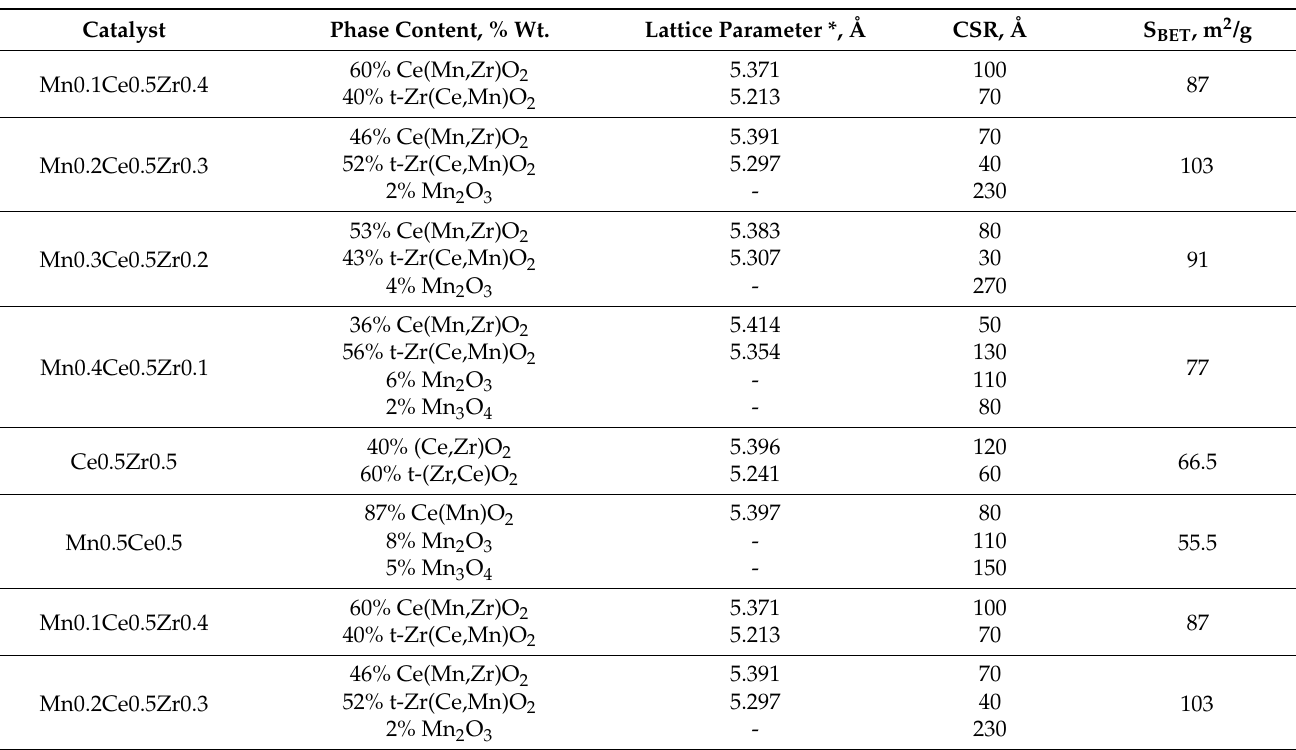
Table 1. Phase composition, lattice parameter of solid solution (Ce(Mn,Zr)O 2 , and t-Zr(Ce,Mn)O 2 CSR and surface area of (Mn,Zr)0.5Ce0.5